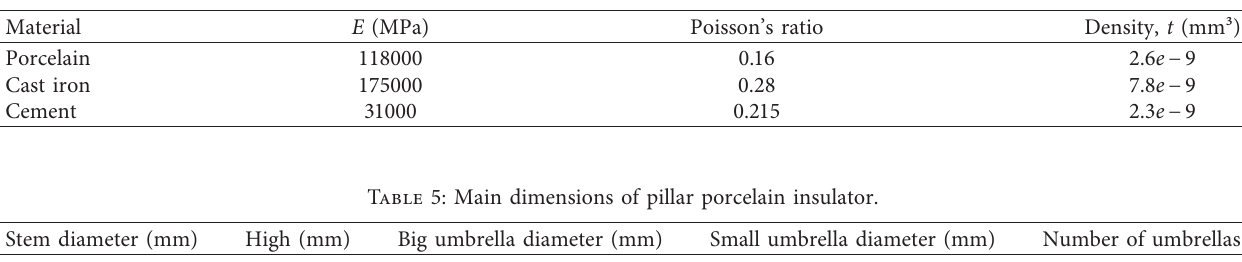
Figure 16: 3D model of pillar porcelain insulator. Table 4: Material parameters of pillar porcelain insulator.